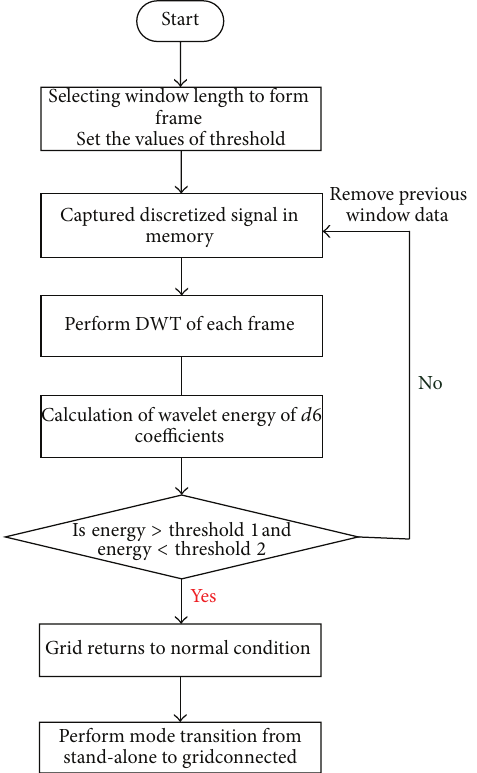
Figure 7: Flowchart for returning to grid normal operation.